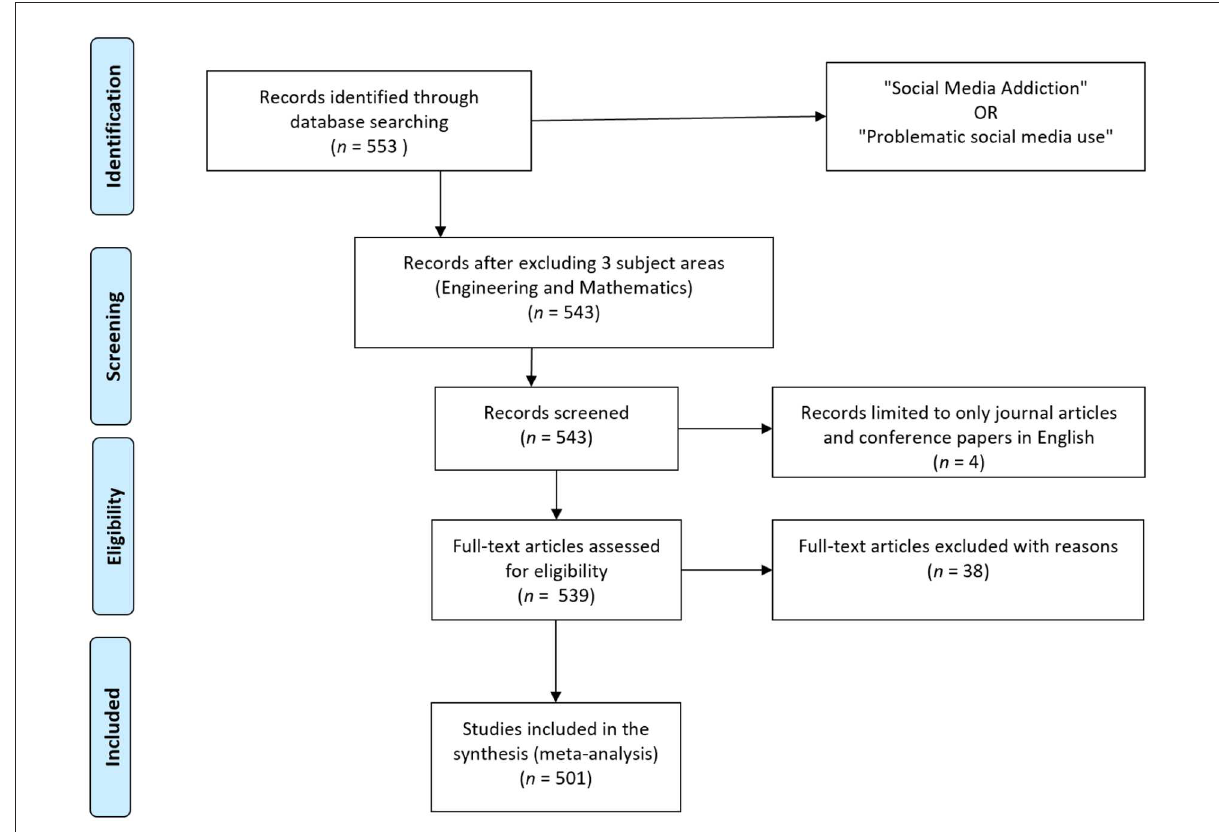
FIGURE1 Preferred reporting items for systematic reviews and meta-analysis (PRISMA) flowchart showing the search procedures used in the